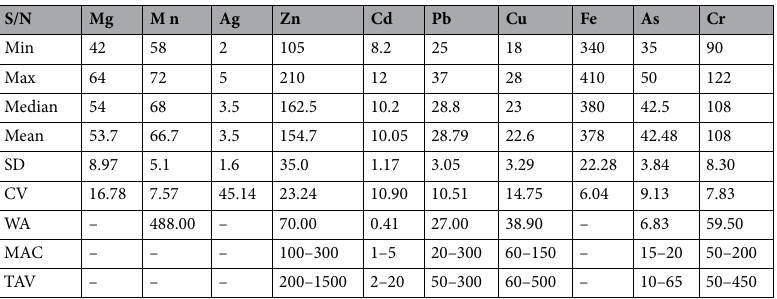
Table 3. Concentration of HMs in the selected top-soil within the study area in ppm. WA world/global average for background contents, MAC maximum allowable concentration in soil, TAV trigger action value 4,43– 45 .